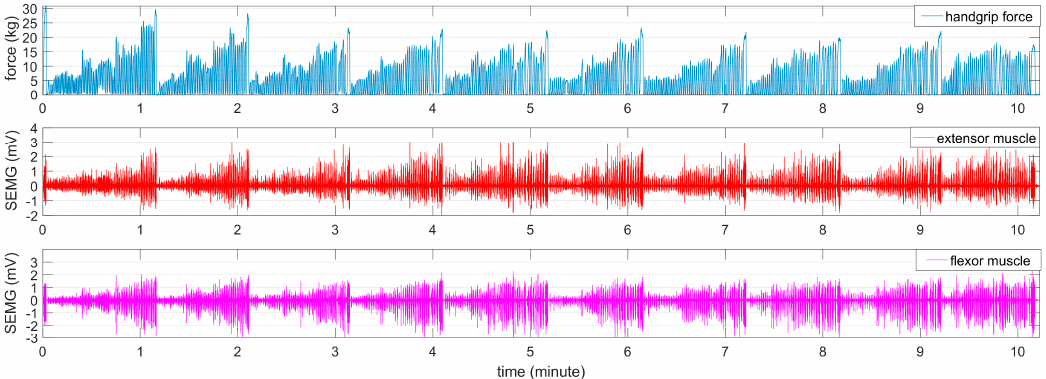
Figure 2. The process of the force-varying analysis task.